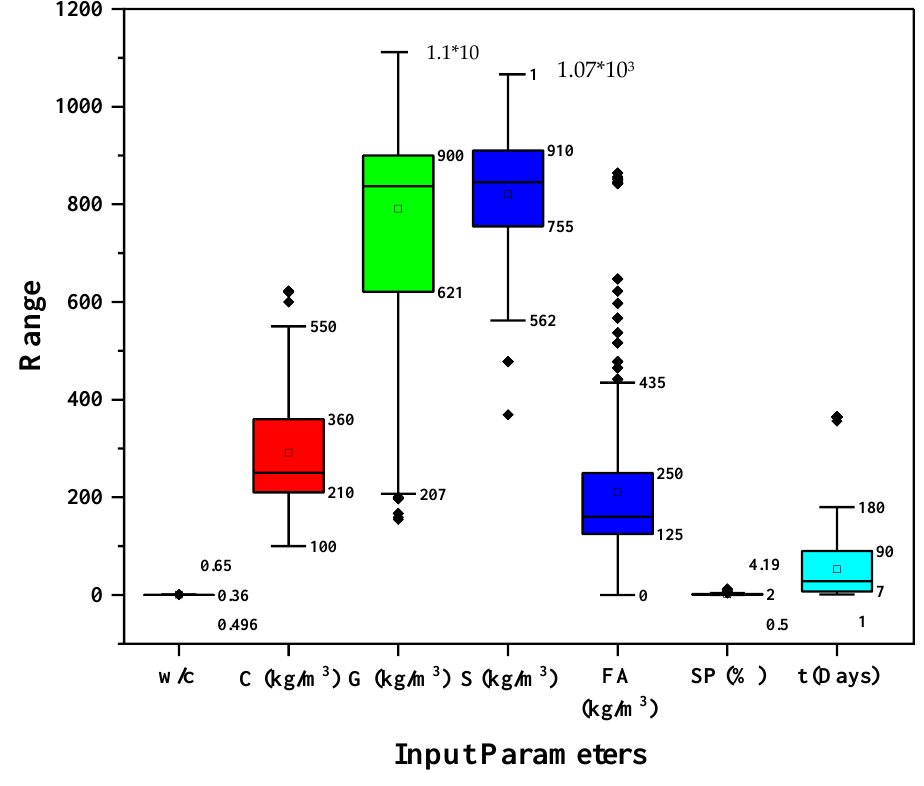
Figure 4. Boxplot for model input parameters.